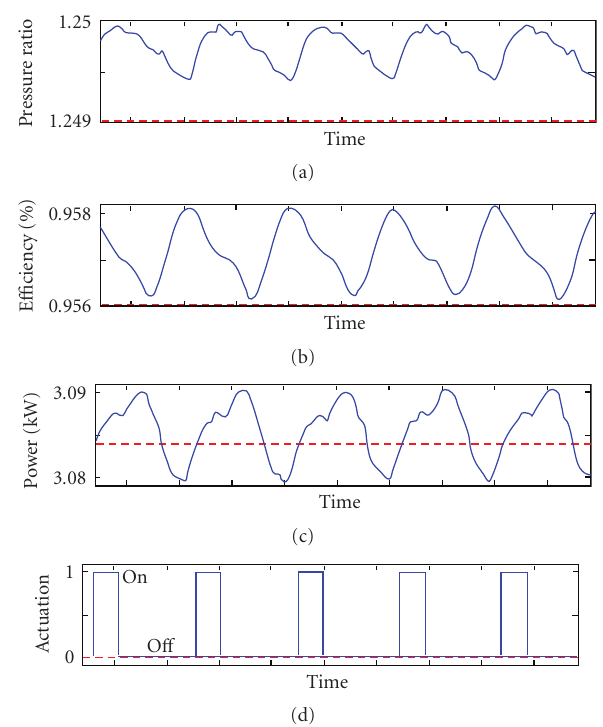
Figure 14: Variation of the flow properties over time for case 12 (solid line) and comparison with the reference case (case 1) (dashed